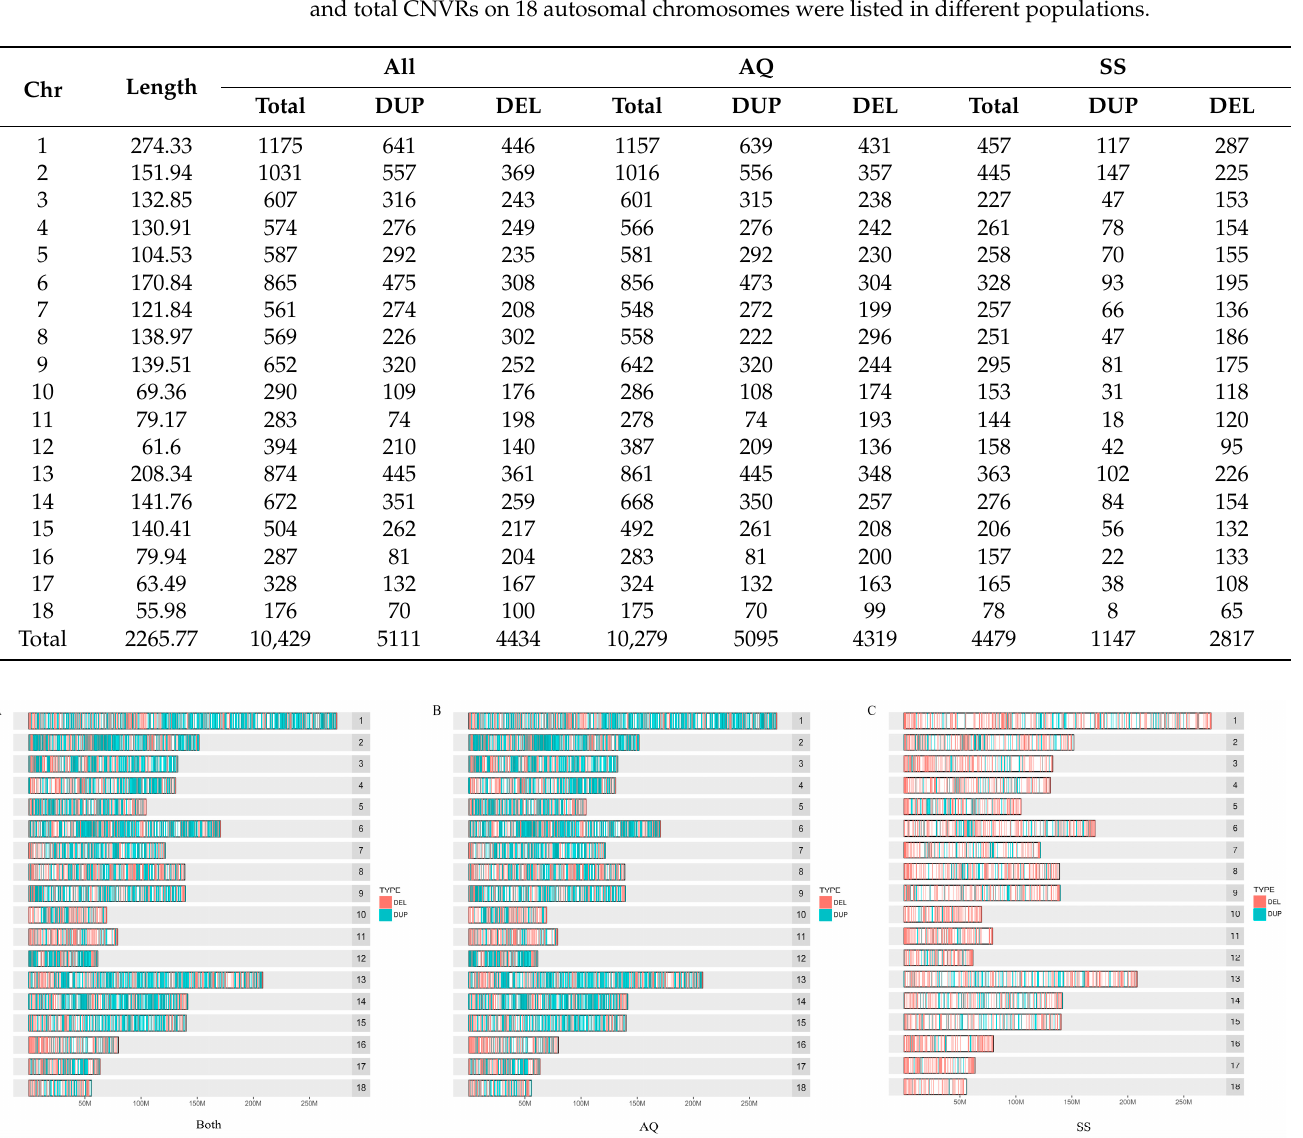
Figure 1. The distributions of CNVRs on 18 autosomal chromosomes in both populations ( A ) and each individual population; ( B ) represents AQ and ( C ) represents SS. The CNVRs were classified into two types: the red and light blue colors represent deletions and duplications,